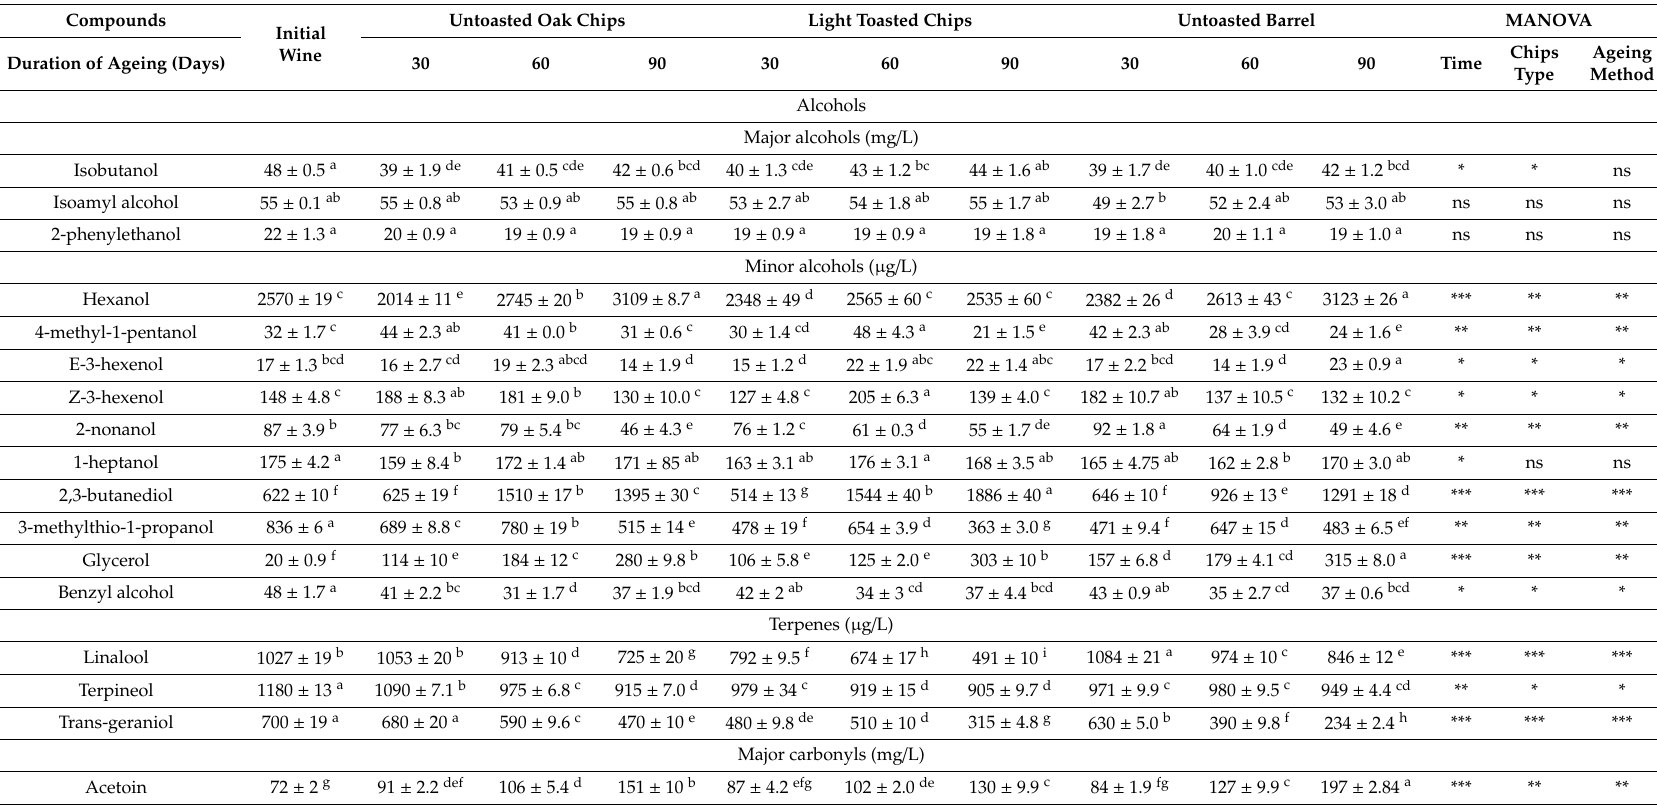
Table 2. Quantitative analysis of volatile compounds of white wines aged with oak chips and barrel. All values are expressed as means (mg / L and µ g / L) ± standard deviation (SD). Multivariate analysis of variance (MANOVA) taking as factors duration of ageing (30, 60, and 90 days), chips types (untoasted and light toasted), and ageing method. The results are expressed in equivalents of phenyl